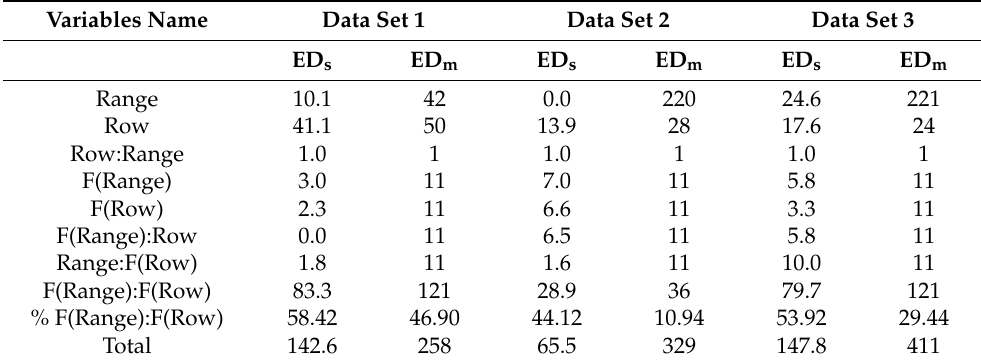
Table 4. Summary of effective spatial dimension (EDs) of the smooth surface components fitted by the SpATS model and effect dimension from the OLD model (ED m ) from the three data